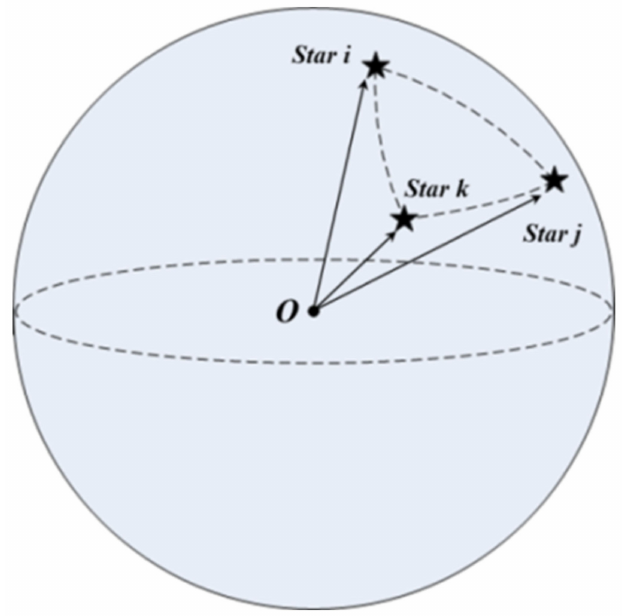
Figure 1. Illustration of the triangle